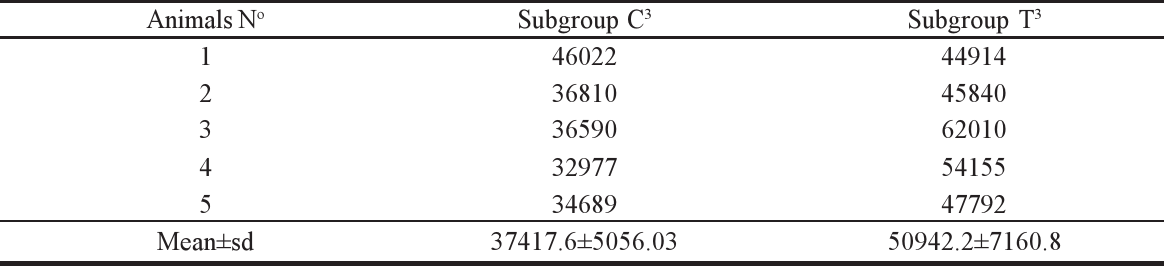
TABLE 3 - Histopathologic mean density of inflammatory elements in the subgroups observed for ten